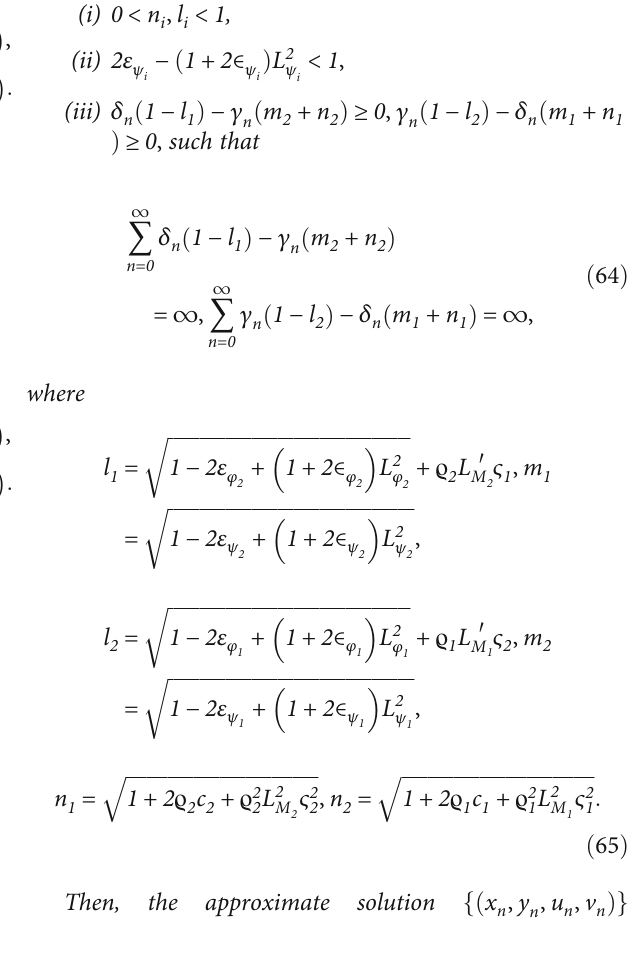
Algorithm 8. For any given ð x 0 , y 0 Þ ∈ Ω 1 × Ω 2 , we choose u 0 ∈ P 1 ð x 0 Þ and v 0 and from (54) and (55),